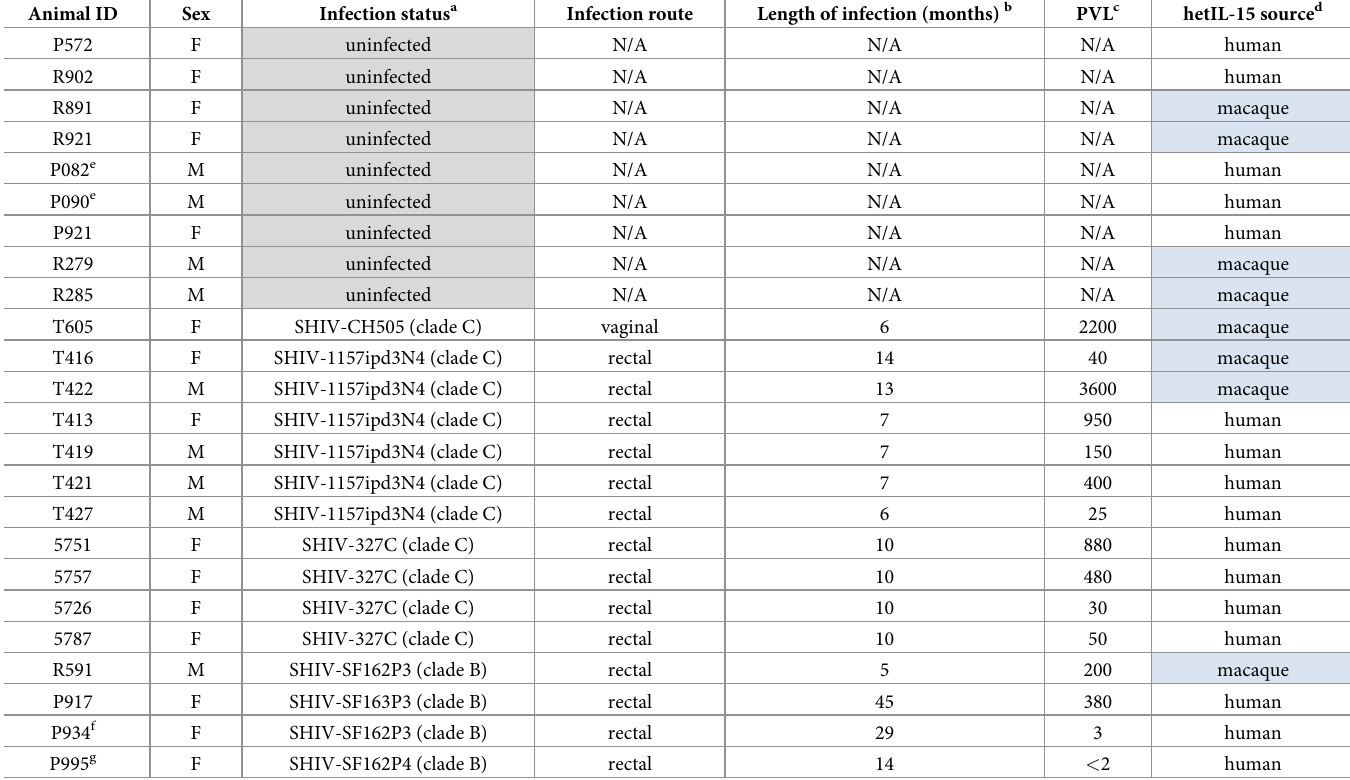
Table 1. Macaques treated SC with